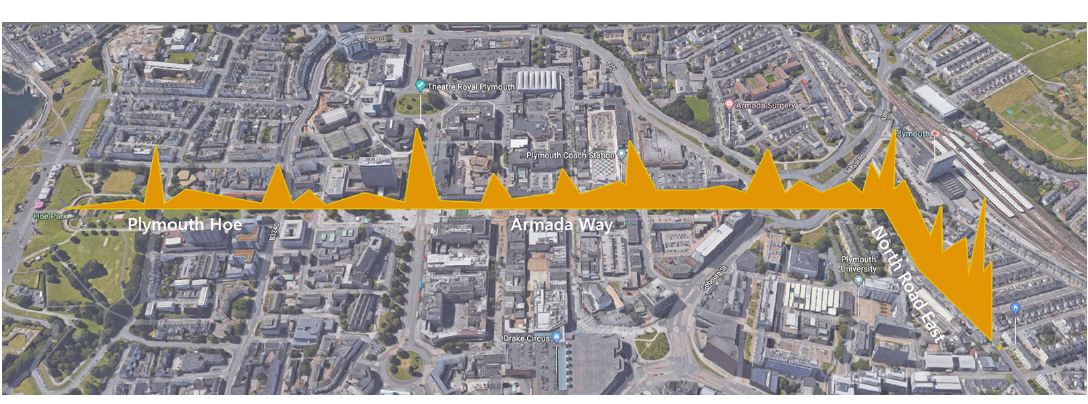
Figure 9. Average of all the participant’s stress levels combined and visualised onto the map of Plymouth City Centre, showing the ‘peaks’ of negative emotional response at road crossings and junctions.